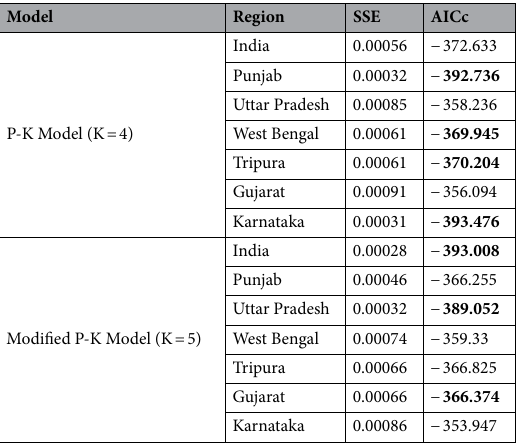
Table 2. Minimized sum of square (SSE) and AICc values under P-K Model and Modified P-K Model for India and the 6 selected states. The least value of AICc is written in the bold case for each